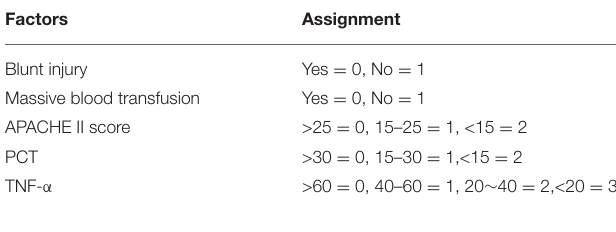
TABLE 2 | Assignment for multivariate analysis of factors.